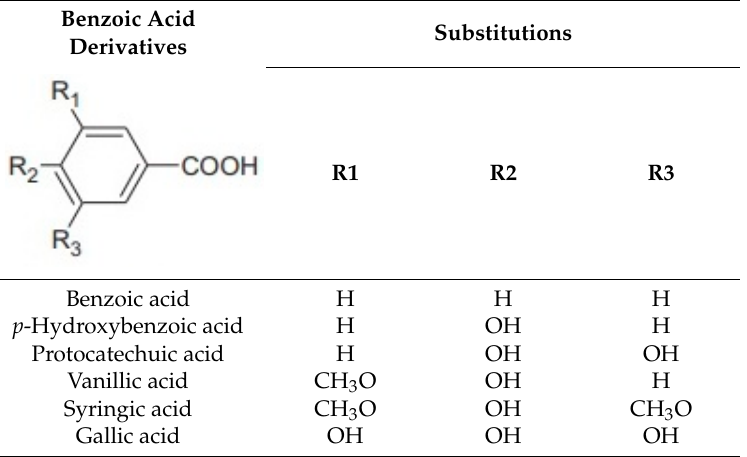
Table 3. Benzoic acids derivates.